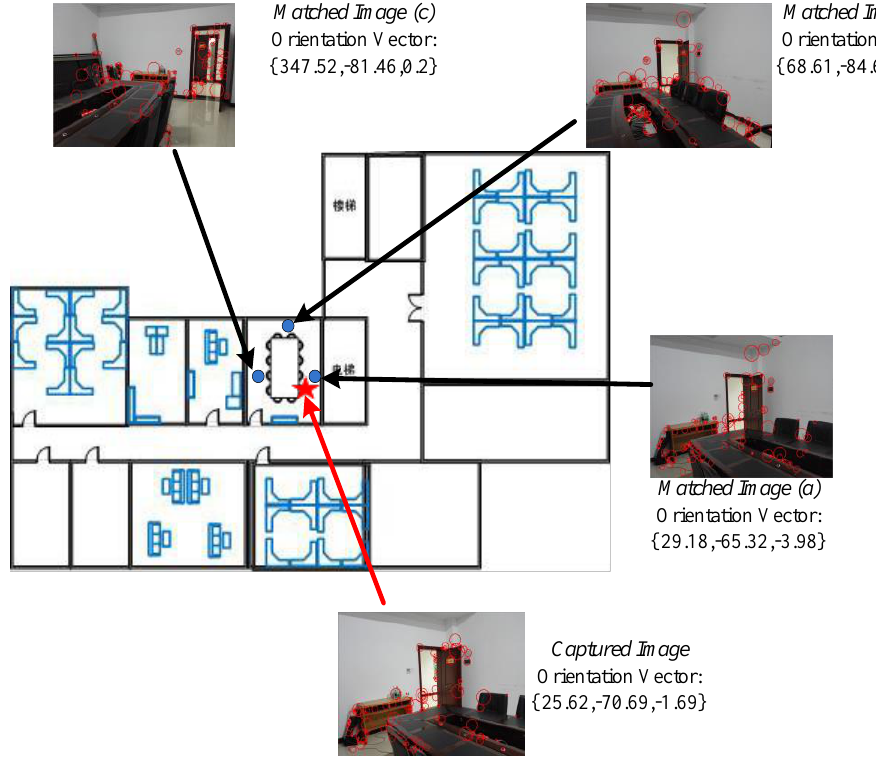
Figure 9. Comparison of image and orientation matching.